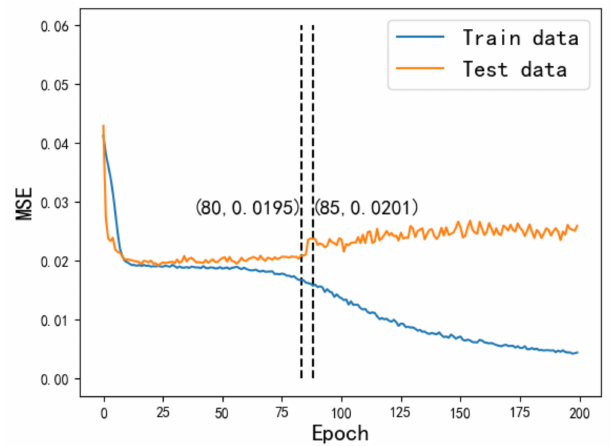
Figure 8. The early stopping method’s training effect